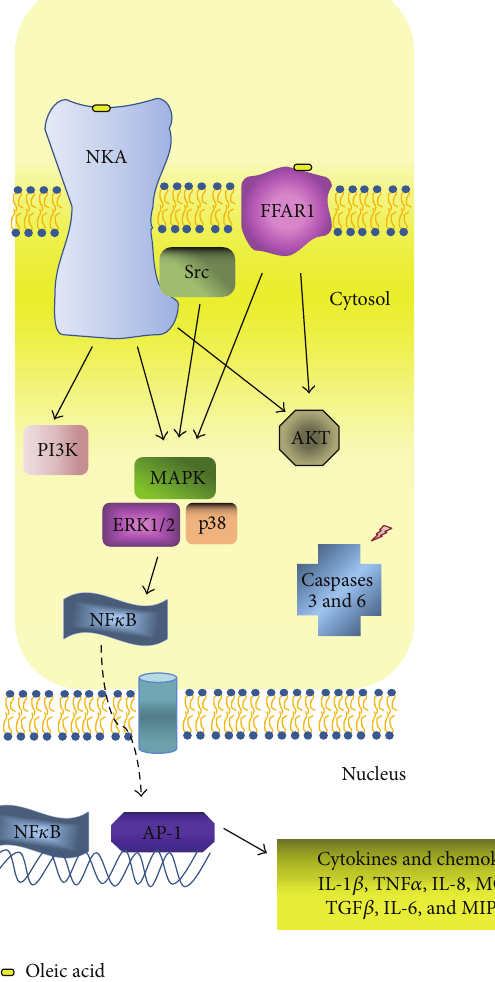
Figure 2: Intracellular pathways activated in oleic acid-induced lung injury and inflammation. Oleic acid triggers intracellular pathways through different receptors ending up in inflammatory mediator production and/or cell death. MAPK: mitogen-activated protein kinases, ERK1/2: extracellular signal-regulated kinases, NF 𝜅 B: nuclear factor kappa-light-chain-enhancer of activated B cells, PI3K: phosphatidylinositol 3-kinase, AKT: protein kinase B, NLRC4: NLR family CARD domain-containing protein 4, MyD88: myeloid differentiation primary response gene 88, AP-1: activator protein 1, TLR: toll-like receptor, IL: interleukin, MIP: macrophage inflammatory protein, FFAR1: free fatty acid receptor 1, MCP1: monocyte chemotactic protein 1, TGF 𝛽 : transforming growth factor beta, and TNF 𝛼 : tumor necrosis factor